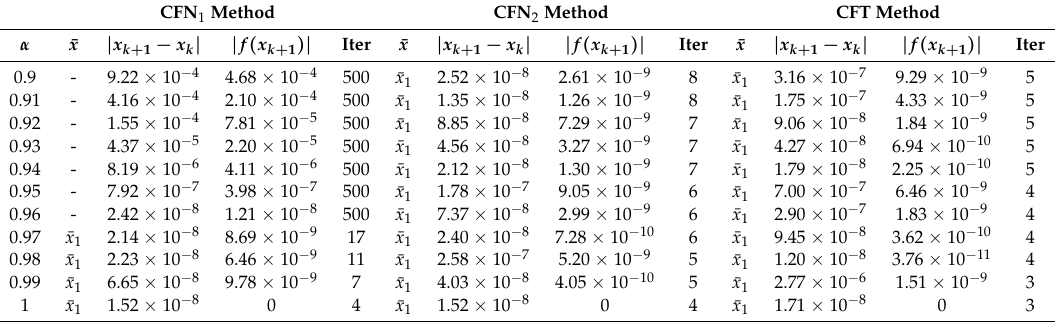
Table 5. Fractional Newton and Traub-type results for f 2 ( x ) with Caputo derivative and initial estimation x 0 =